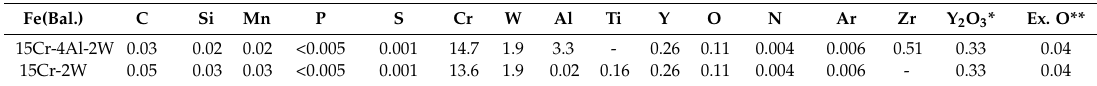
Table 1. Chemical compositions of the ODS steels. The composition of Y 2 O 3 * is that of measured Y 2 O 3 powder, and Ex.O** is a substitution of O forming Y 2 O 3 from the measured total O in the steels.